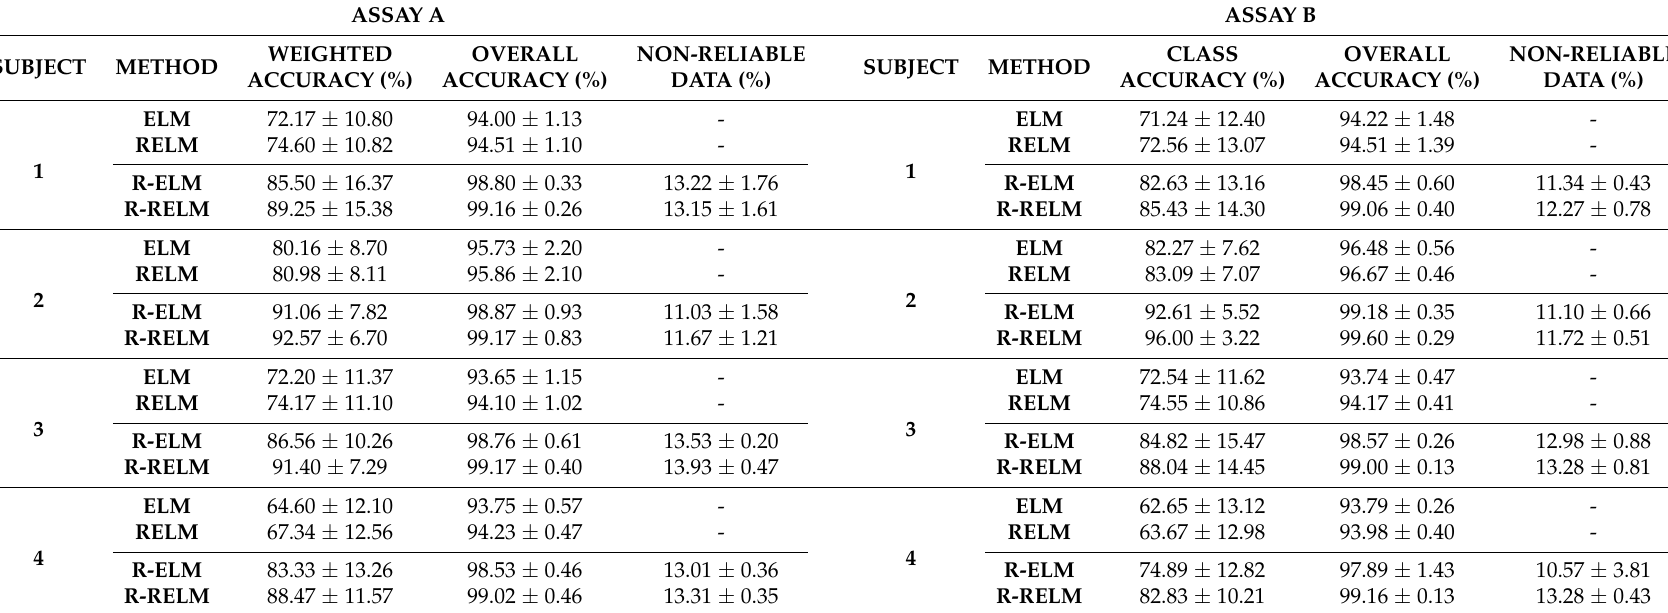
Table 2. Mean accuracy rates achieved considering the three repetitions for each assay. The results are divided by assay, subject, method, and accuracy. For the reliable versions of the classifiers, the amount of discarded data is also present. R-RELM, Reliable Regularized